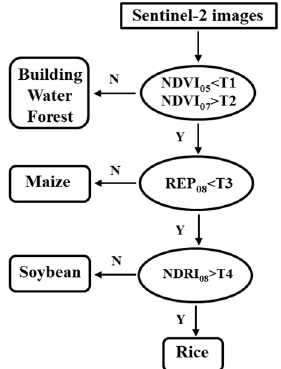
Figure 5. Decision tree for crop classification on the Northeast Plain. T1-4 represent threshold values of each procedure, with slight differences under subregions.